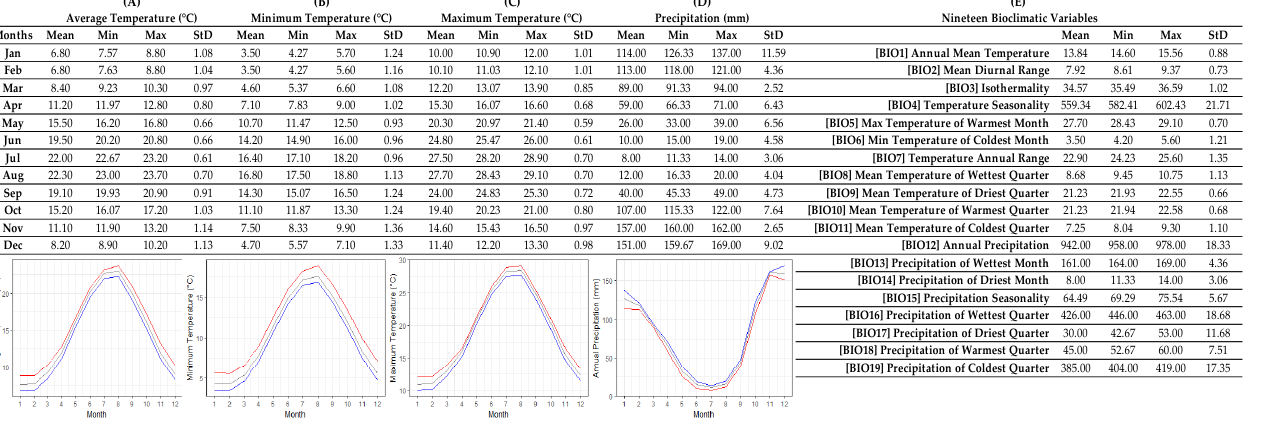
Figure 5. R-derived ecological profile of the wild-growing populations of Thymus holosericeus in Cephalonia, Zakynthos and Lefkada islands, Ionian Sea, Greece. In each case ( A – E ), the minimum, maximum, average, and standard deviation is shown. Line graphs ( A – C ) illustrate the minimum (blue lines), maximum (red lines), and mean (grey lines) monthly values for temperature (°C) and the line graph ( D ) illustrates the minimum (red lines), maximum (blue lines), and mean (grey lines) monthly values for precipitation (mm). ( A ) Minimum temperatures per month (°C), ( B ) maximum temperatures per month (°C), ( C ) average temperatures per month (°C), ( D ) precipitation per month (mm), ( E ) values for 19 bioclimatic variables (Supplementary Material Table S1). All data were extracted from WorldClim version 2.1.